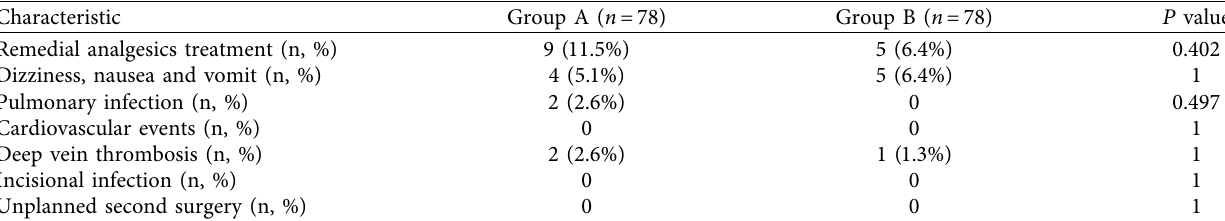
Table 3: Incidence of adverse events and